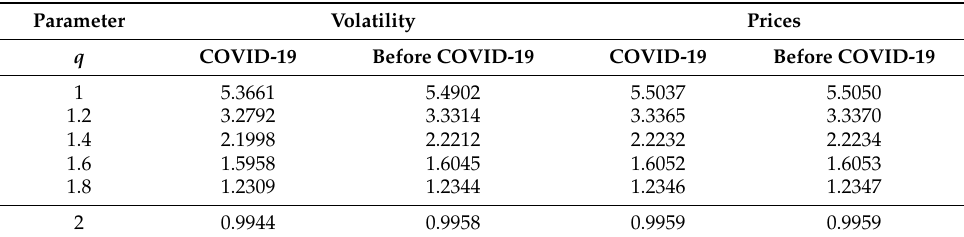
Table 5. Estimates of Tsallis entropy for PSX-100 estimated volatilities and closing prices.